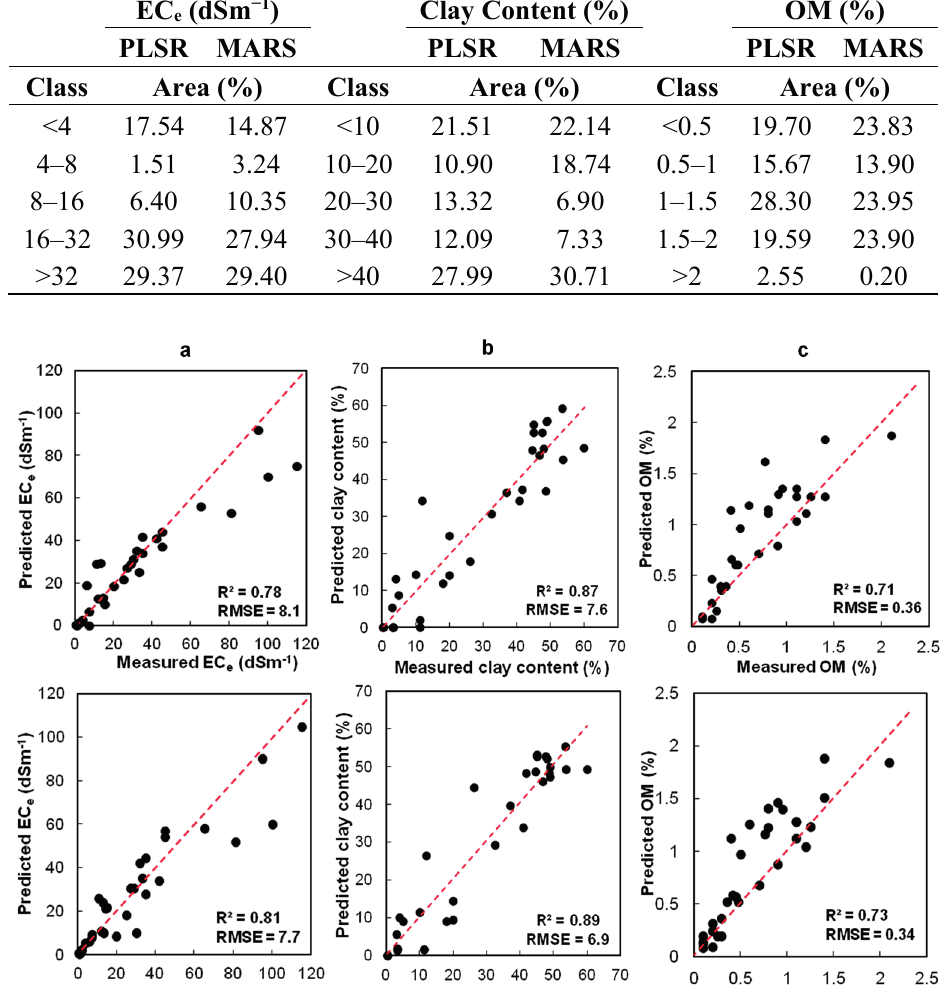
Table 4. Class areas for EC e , clay content and OM for the PLSR and MARS maps.